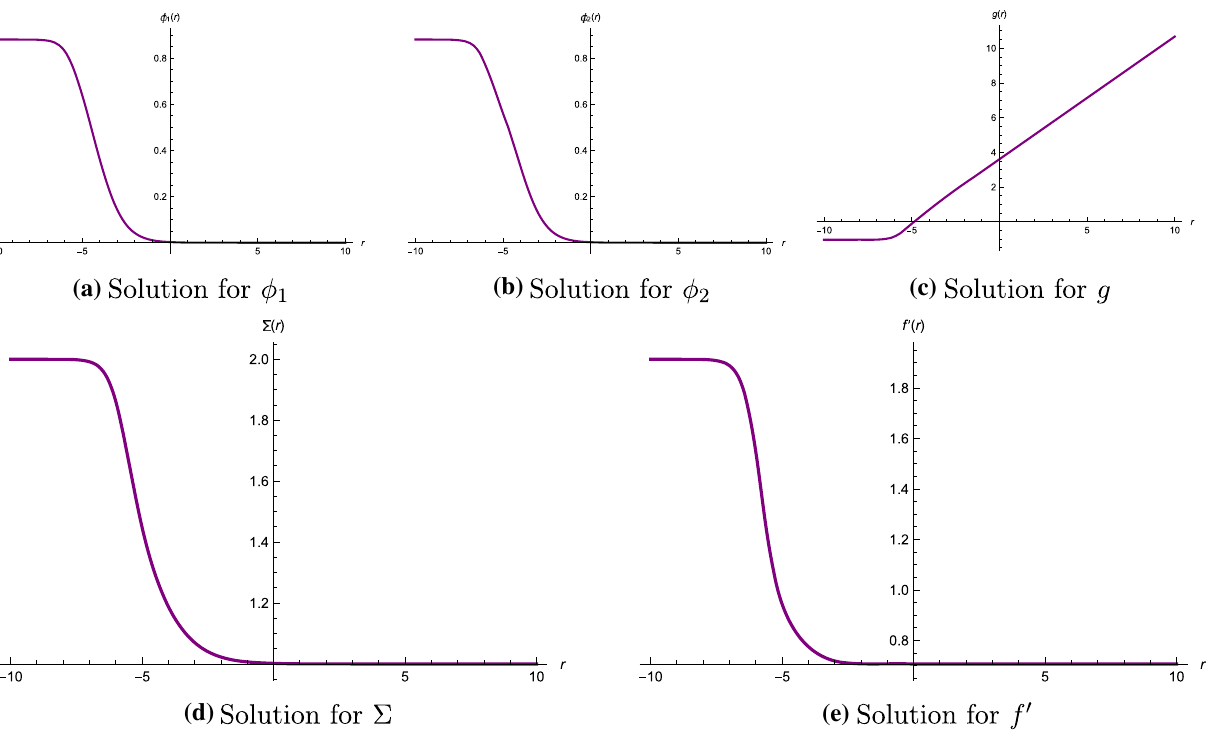
Fig. 4 An RG flow from AdS 5 critical point with U ( 1 ) × SU ( 2 ) × SU ( 2 ) symmetry to AdS 3 × S 2 critical point II for g 1 = 1, g 3 = 2 g 1 and